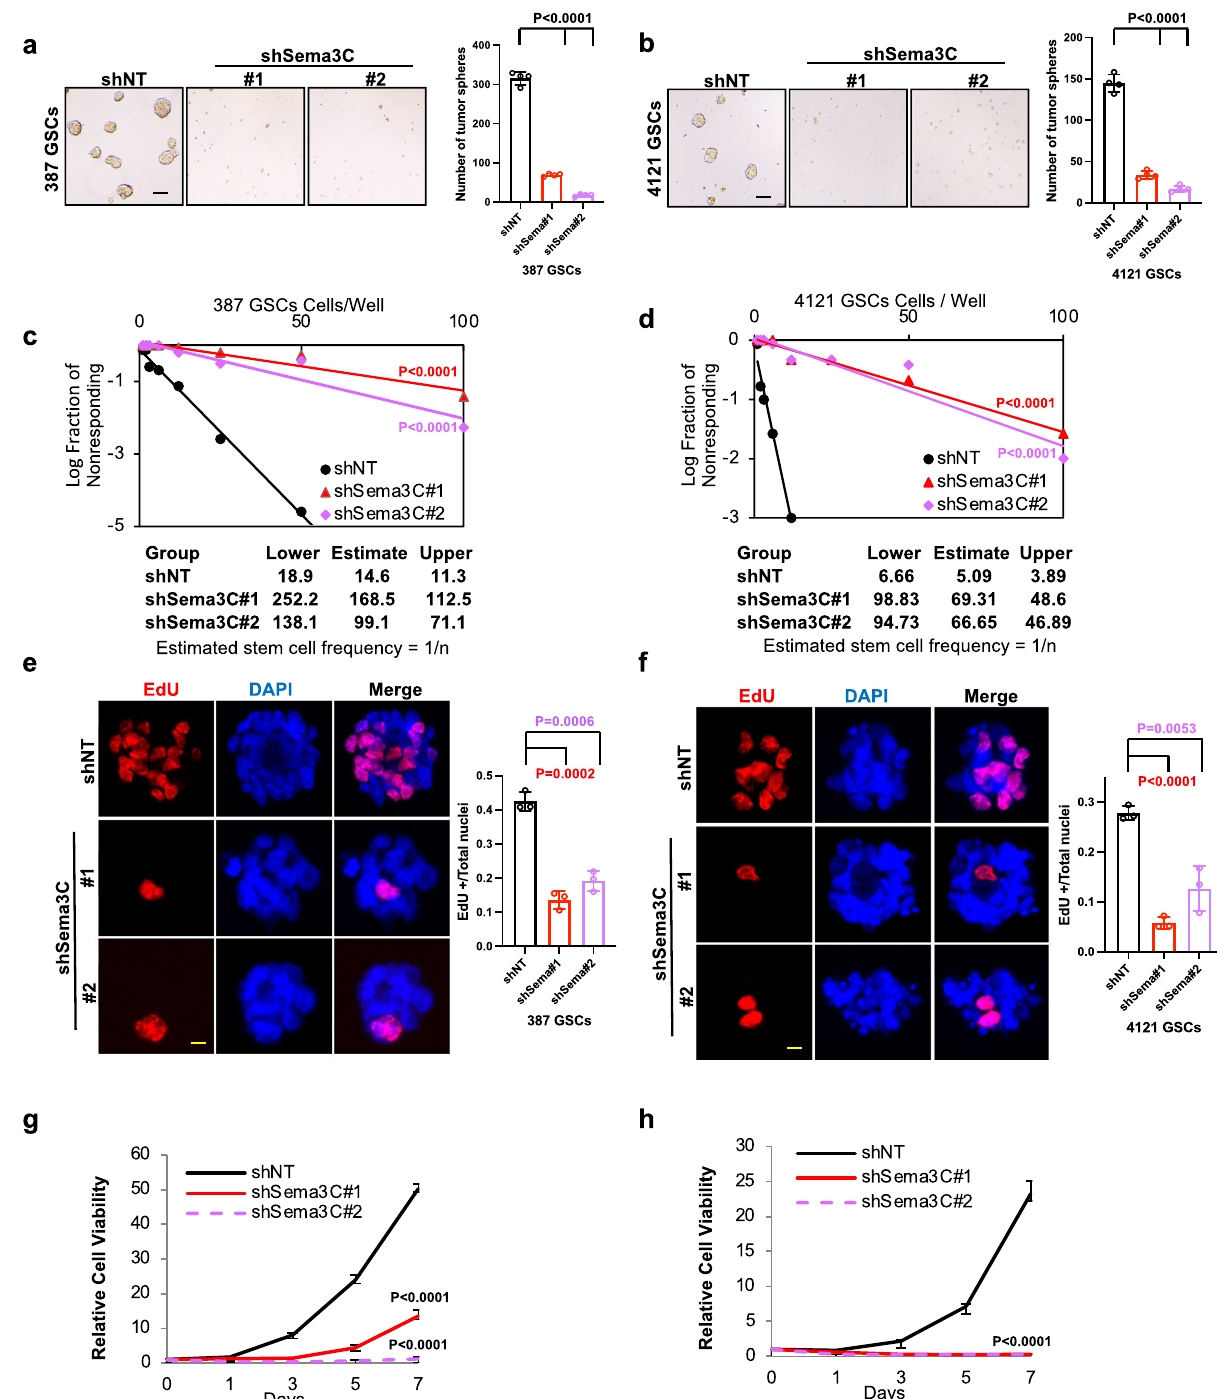
Fig. 2 | Sema3C promotes GSC self-renewal. a , b Left panels: representative tumorsphereimagesof387( a )and4121( b )GSCsaftercontrolshNT,shSema3C#1, and shSema3C#2 knockdown. Scale bar 100 μ M. Right panels: quanti fi cation of tumorspheres afterSema3Cknockdown( n =4 biologicalreplicatesin each group, compared with control unadjusted p <0.0001, error bars: S.D. Scale bar 100 μ M). c , d InvitroextremelimitingdilutionassayinSema3Cknockdown387GSCs( c )and 4121 GSCs ( d ). Tables show estimated stem cell frequencies in control shNT, shSema3C#1, and shSema3C#2 knockdown GSCs with 95% con fi dence intervals ( n =24 replicates in each dose, compared with control unadjusted p <0.0001, error bars: S.D.). e , f Left panels: representative immuno fl uorescence images of